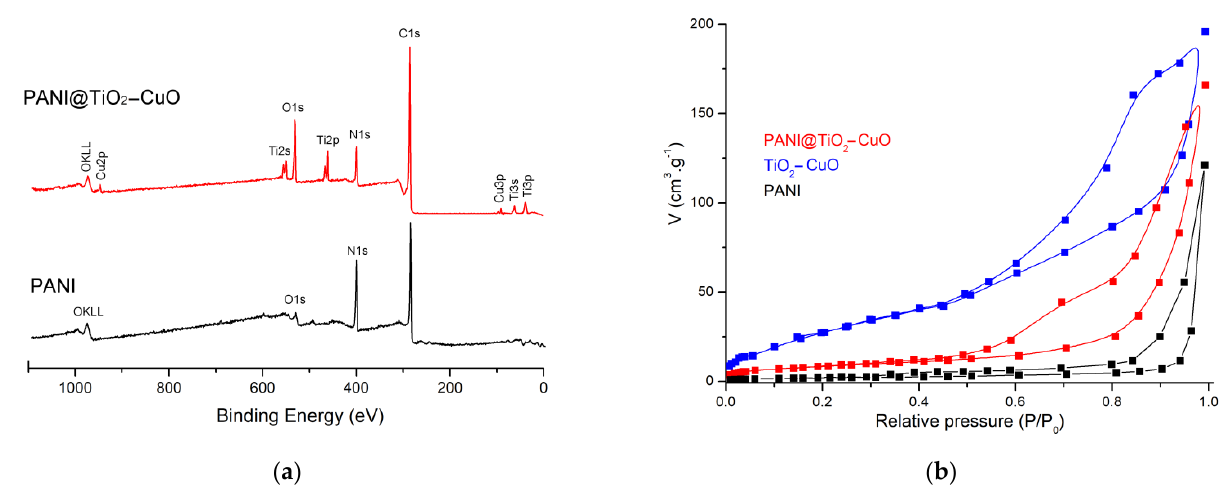
Figure 2. ( a ): Survey XPS spectra and ( b ): N 2 sorption isotherms of samples.